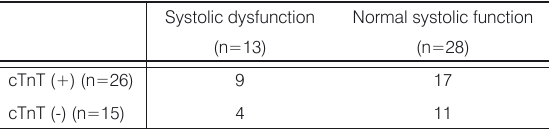
Sensitivity: 9/13= 69% Specificity: 11/28= 39% Positive predictive value: 9/26= 35% Negative predictive value: 11/15=